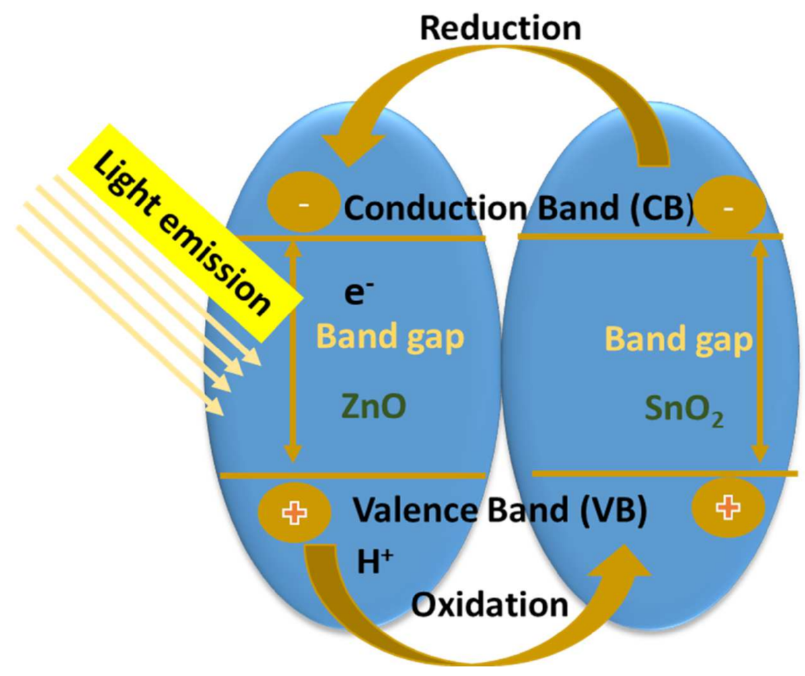
Figure 8. Mechanism of degradation for ZnOSnO